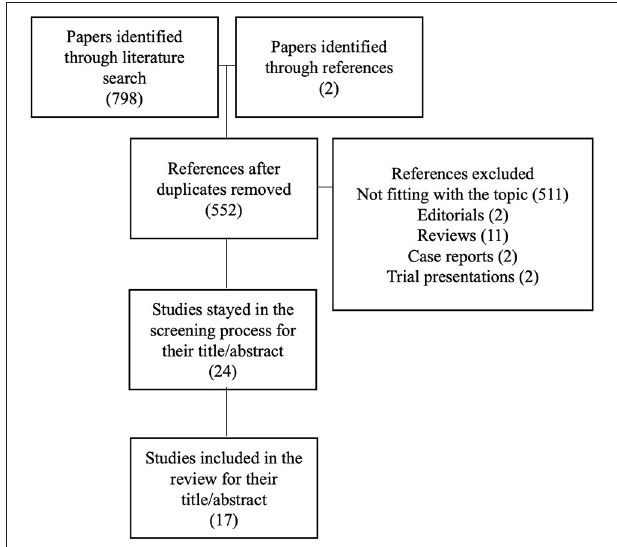
FIGURE 2 | Flow-chart of selection process for the papers included in the systematic